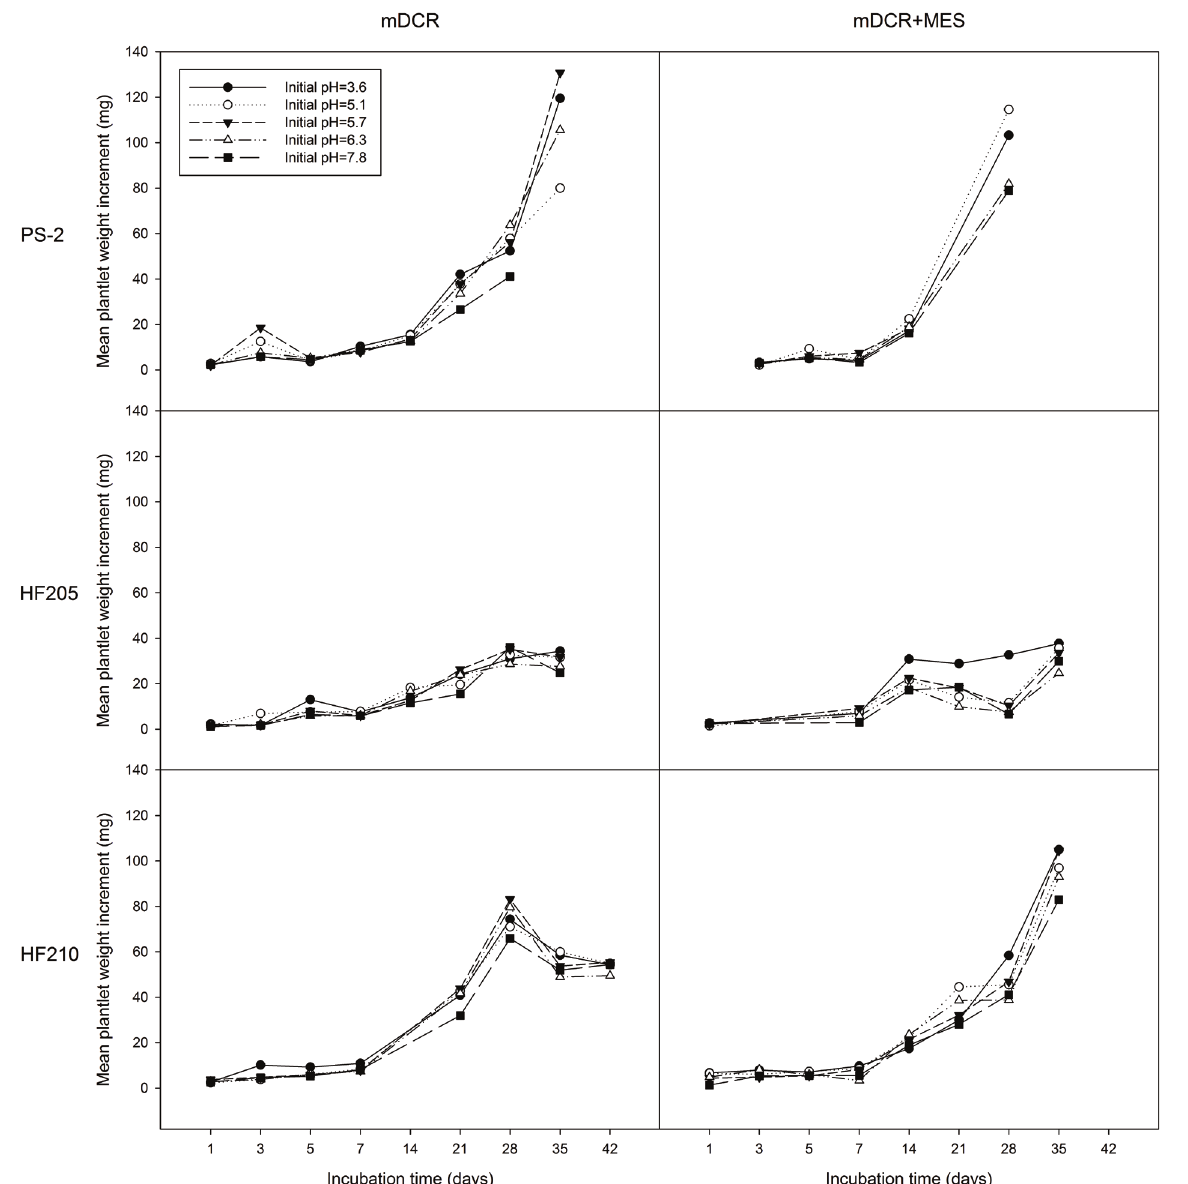
Figure 3. Mean explant weight increment changes (mg) among genotypes and medium types at each initial pH level. Genotypes included one mature genotype, PS-2, and two juvenile genotypes, HF205 and HF210. After surface sterilization and dissection, inner vegetative buds from above three genotypes were placed on either mDCR or mDCR+MES medium at each initial pH level (3.6, 5.1, 5.7, 6.3, and 7.8) for incubation up to 42 days. The buds were incubated in a growth chamber at 25 ° C with light regime adjusted to 16-hour light followed by 8-hour darkness each day. Bud weight change was recorded using an electronic scale when samples reached each incubation time point. Data points represent mean weight increment (mg). Please see Dataset 4 for the raw